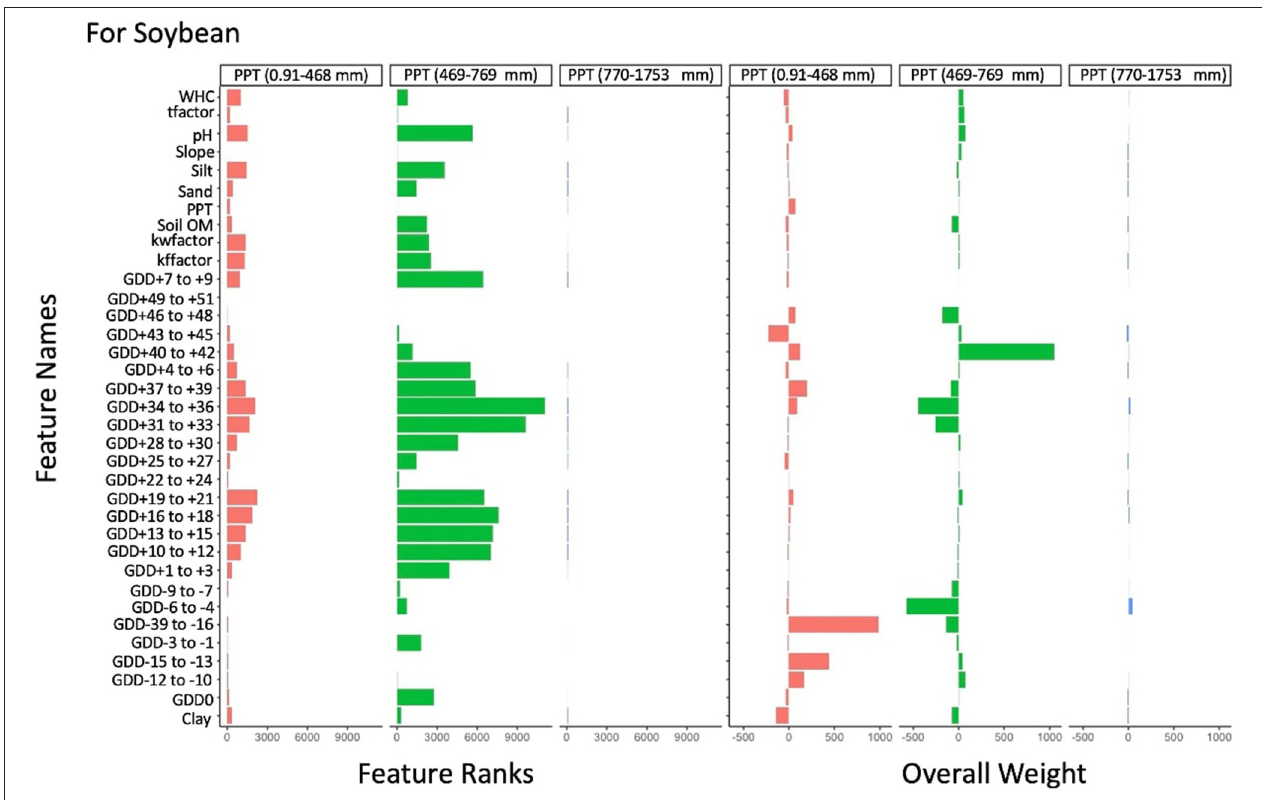
FIGURE 7 | Feature ranks and overall weight of features following explainable machine learning interpretations for soybean for low, medium, and high quartiles of